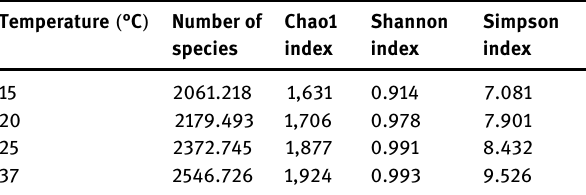
Table 3: Changes in the bacterial diversity index in the anaerobic digestion system of cattle manure at sub - mesophilic temperatures Temperature ( °C ) Number of